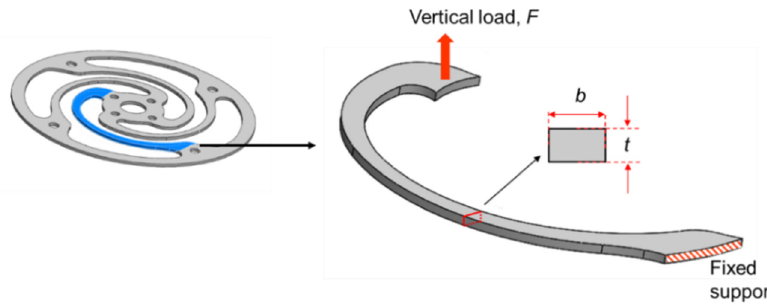
Figure 23. Representation of modeling the spiral of the spring as a simple